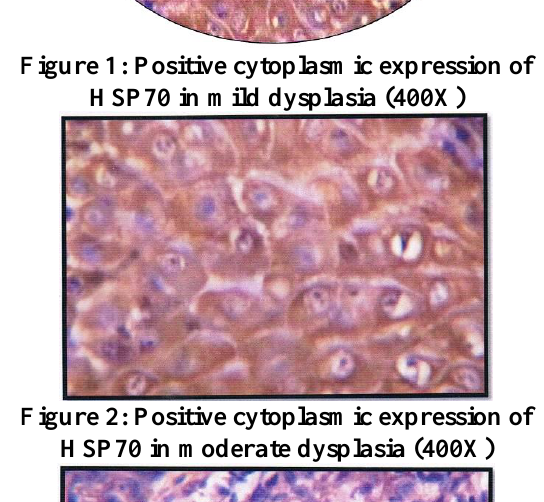
Figure 2: Positive cytoplasmic expression of